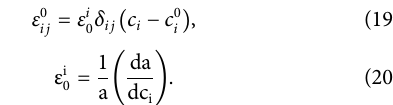
In Eq. 24 , α ( c ) is the linear function of c , α ( c ) (cid:2) c − c 0 , and c 0 represents the initial concentration value. C eff average elastic modulus tensor from the elastic modulus tensor of